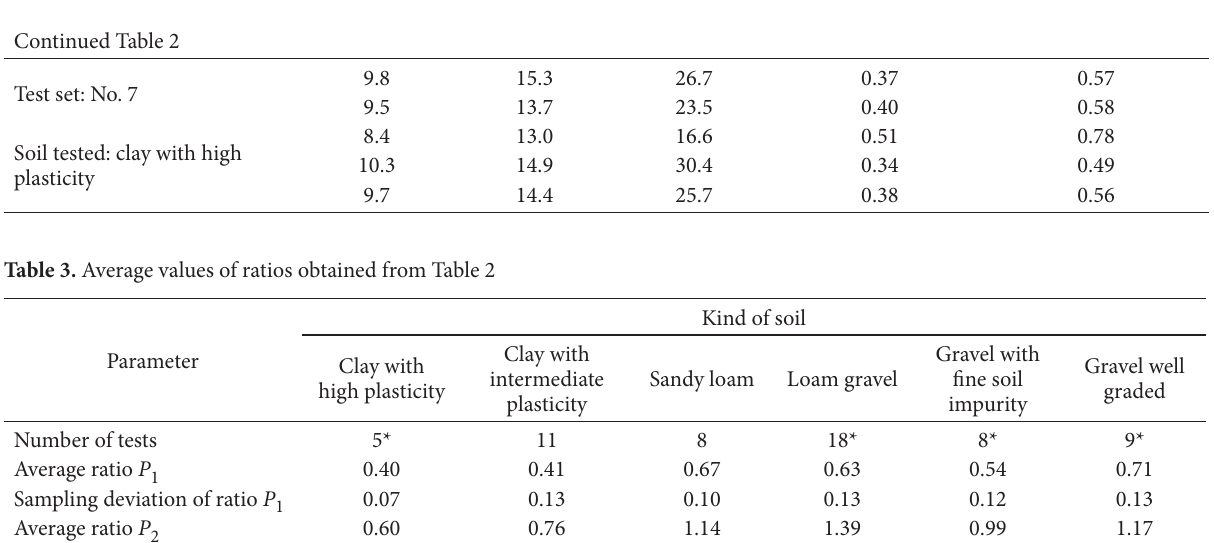
Test set: No. 7 Soil tested: clay with high plasticity